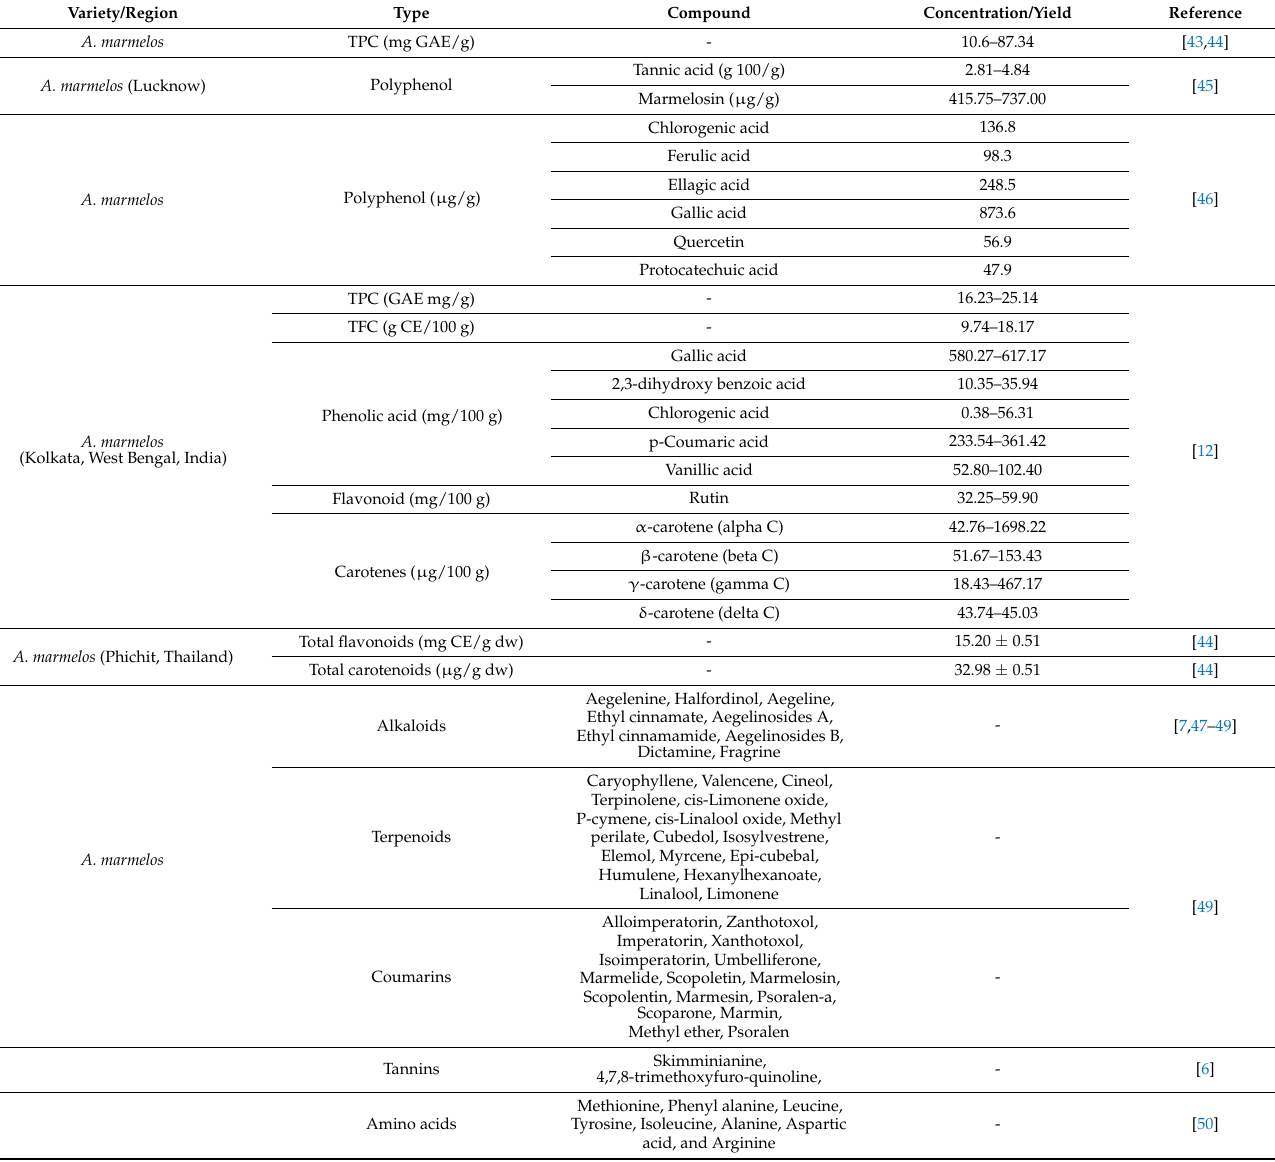
Table 2. Phytochemical profile of Aegle marmelos